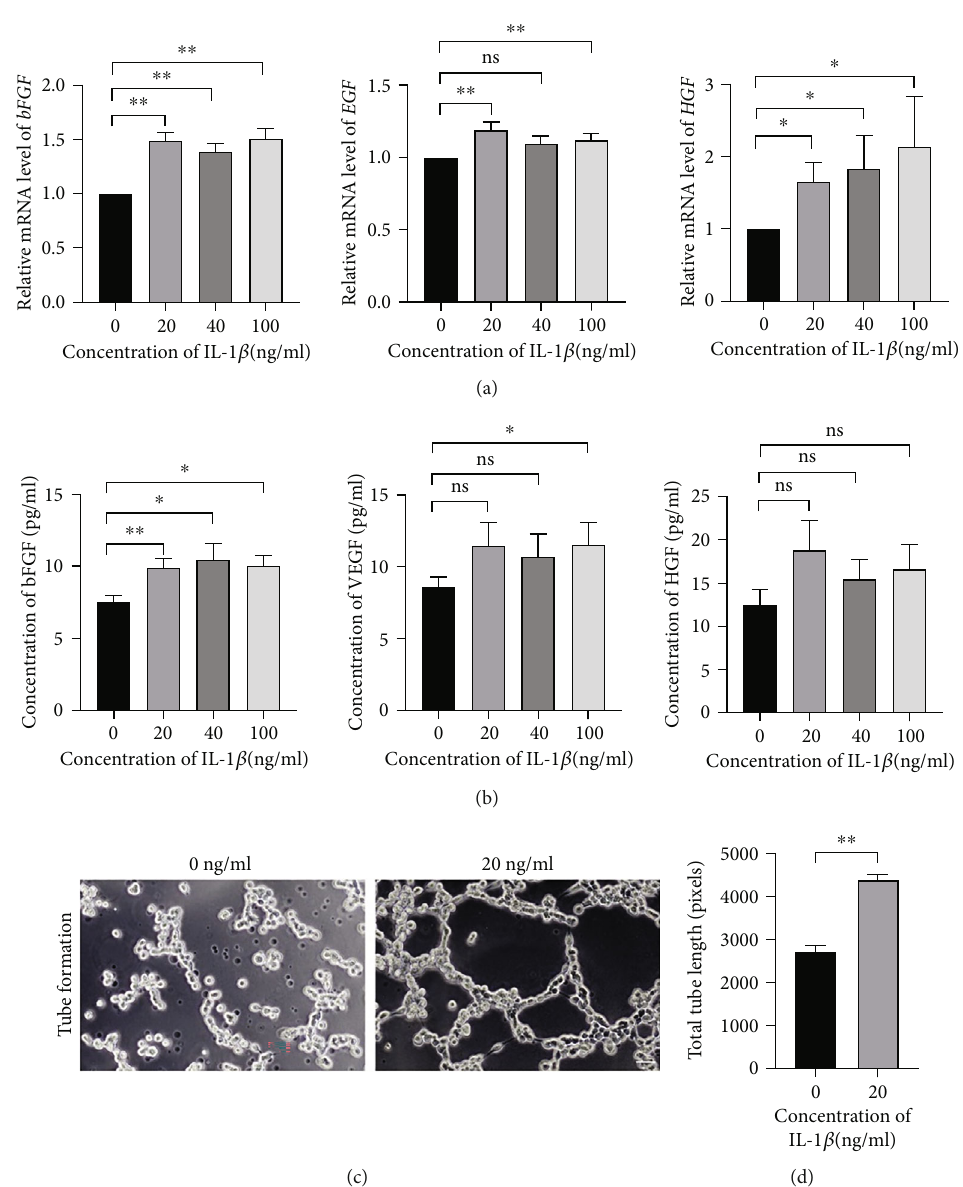
Figure 6: HUC-MSCs responded to the IL-1 β microenvironment with the releasing of neovascularization factors to promote angiogenesis. (a) Quantitation of the relative gene expression of angiogenesis markers ( bFGF , EGF , and HGF ) in the hUC-MSCs with the various concentration of IL-1 β induction. Data was reported as mean ± S : E : M of 3 independent cultures, tested for signi fi cant di ff erence ( ∗ P < 0 : 05 , ∗∗ P < 0 : 01 , ns=nonsigni fi cant) using Student ’ s t -test. (b) Luminex analyzed the protein concentration of angiogenesis markers (bFGF, VEGF, and HGF) in the stimulated hUC-MSCs supernatant. Data was reported as mean ± S : E : M of 3 independent cultures supernatant, tested for signi fi cant di ff erence ( ∗ P < 0 : 05 , ∗∗ P < 0 : 01 , ns=nonsigni fi cant) using Student ’ s t -test. (c) Phase contrast images of HUVEC cultured in the hUC-MSCs supernatant with or without the IL-1 β induction. Scale bar = 50 μ m. (d) Quanti fi cation of tube length of HUVEC culturing within the supernatant from the hUC-MSCs with or without the IL-1 β induction. Results were presented as mean ± S : E : M of approximately 60 pictures from 3 independent cultures, tested for signi fi cant di ff erence ( ∗∗ P < 0 : 01 ) using Mann – Whitney rank sum